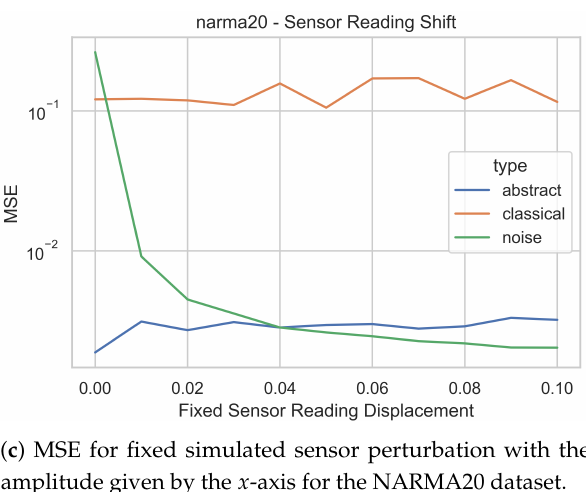
Figure 10. The average MSE with standard deviations for fixed simulated sensor reading displace- ments for the datasets ( a ) Hénon, ( b ) NARMA10 and ( c ) NARMA20